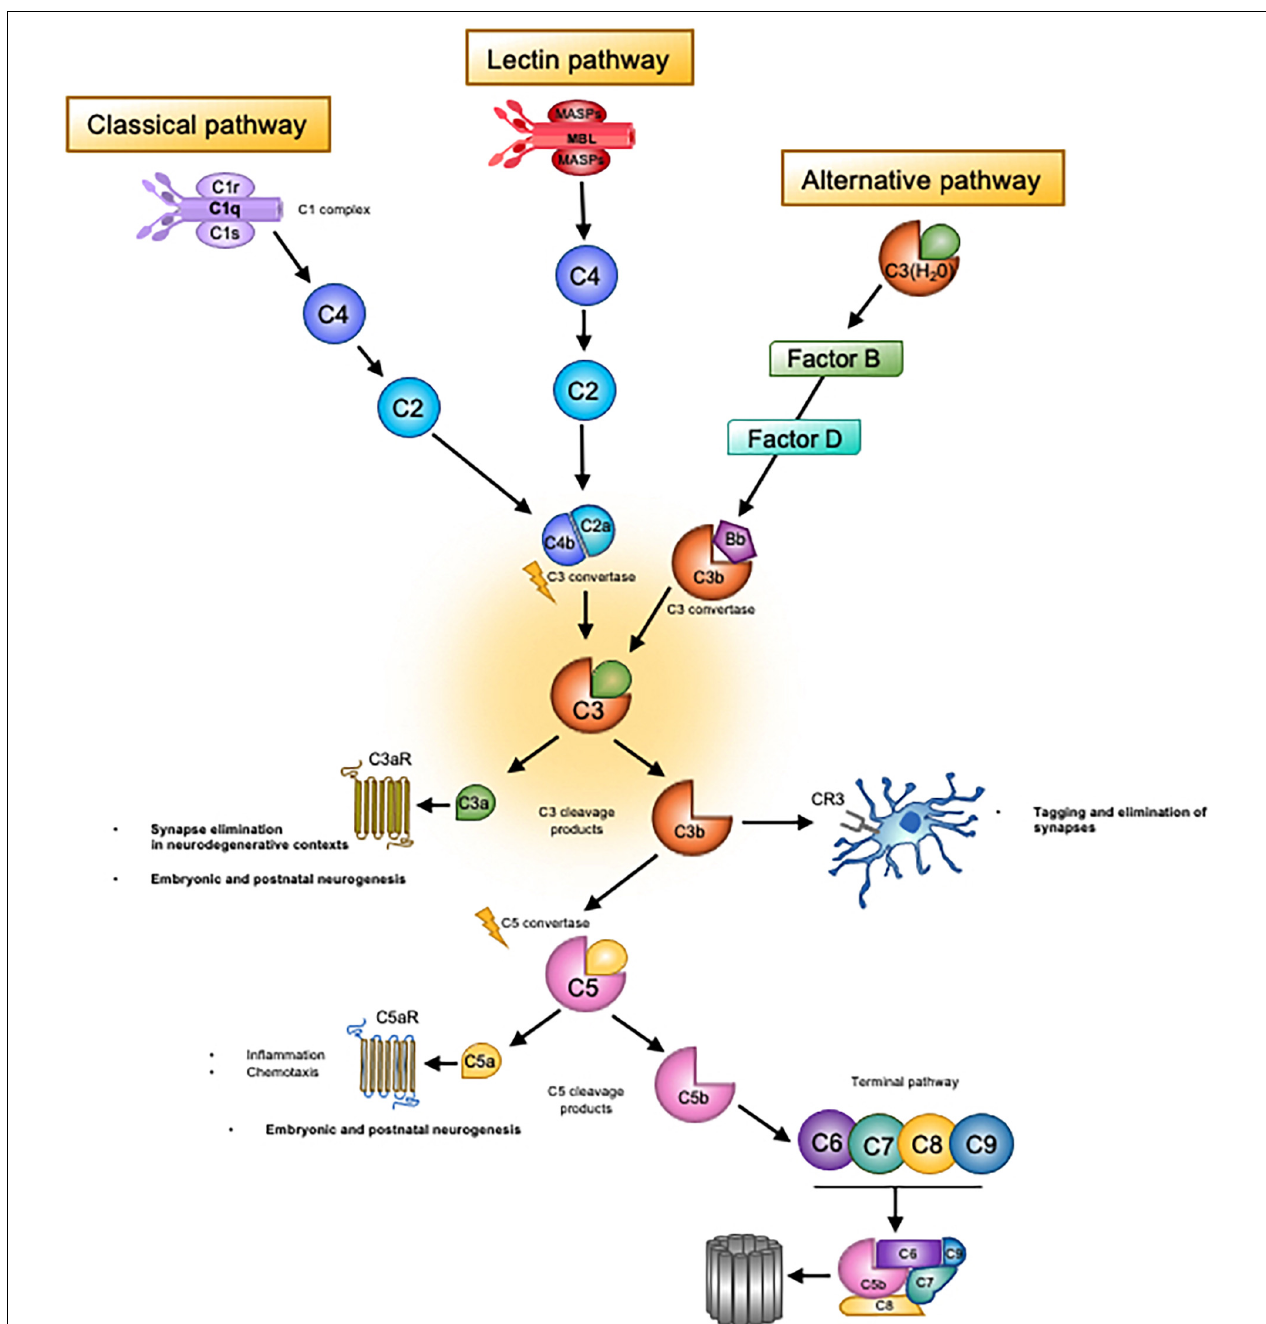
FIGURE 1 | Overview of the complement system. Complement system consists of three main ‘recognition systems’; the classical pathway, the alternative pathway, the lectin pathway. Each pathway is initiated by different stimuli, which can be either exogenous or endogenous danger signals or pathogen-associated molecular patterns. Activation of the classical pathway is triggered by detection of antibody-antigen complexes by the initiator molecule of the classical pathway, C1q. C1q is then able to activate C1r and C1s, which cleave C4 and C2 to form the C3 convertase, C4b2a. The lectin pathway is initiated by the recognition of carbohydrates such as mannose upon pathogen surfaces by mannan-binding lectin (MBL), a molecule homologous to C1q of the classical pathway. MBL activates two serine proteases, MASP-1 and MASP-2, which then act to cleave classical pathway components C4 and C2. Activation then proceeds in the same manner as the classical pathway, eventually leading to generation of the C4b2a convertase. Unlike the classical and lectin pathways, the alternative pathway does not require pathogen recognition to initiate activation. Rather, there exists continuous low-level activation termed C3 tickover. In this process, the internal thioester bond of circulating C3 molecules is hydrolysed due to nucleophilic attack by H 2 O. This process occurs at a slow yet constant rate, leading to the formation of C 3 (H 2 O). After a series of interactions with C3b and regulatory molecules (Factor B and Factor D), the alternative pathway convertase is formed, C3bBb. Convertase complexes resulting from